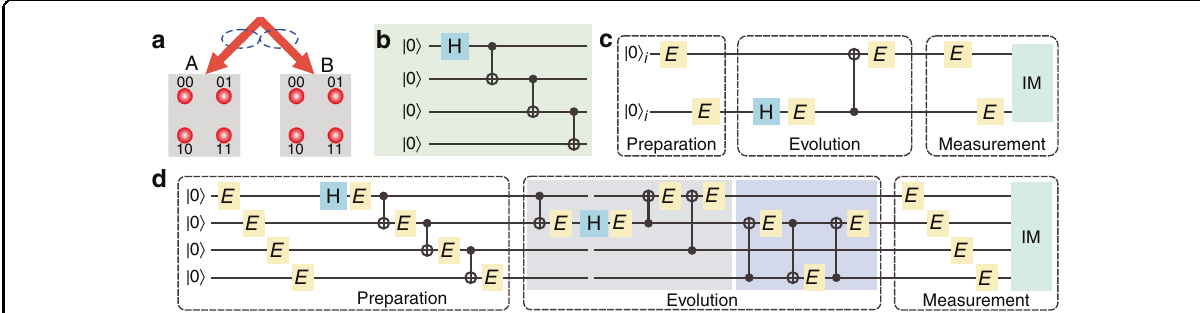
Fig. 1 Quantum circuits with fault-tolerant gates under the presence of errors. a Spatial modes on each side, A and B which are bipartite entangled, are marked as |00 〉 , |01 〉 , |10 〉 , and |11 〉 (ket symbols are omitted for brevity). The basis of four physical qubits, say |0001 〉 , is denoted as the coincidence count between the mode |00 〉 on A side and the mode |01 〉 on the B side. b The circuit of preparing logical qubit state |00 〉 l from the initial state |0000 〉 . c Non-encoded circuit includes stages of the preparation, evolution, and measurement starting from logical state |00 〉 l with errors. Hadamard gate (H) is applied to the second logical qubit followed by a CNOT gate CNOT 21 . Error gates E are imported throughout the circuit. IM denotes ideal measurement. d The complete fault-tolerant circuit implementing logical operations H 2 and CNOT 21 . In CNOT operation, error gate E affects only the target